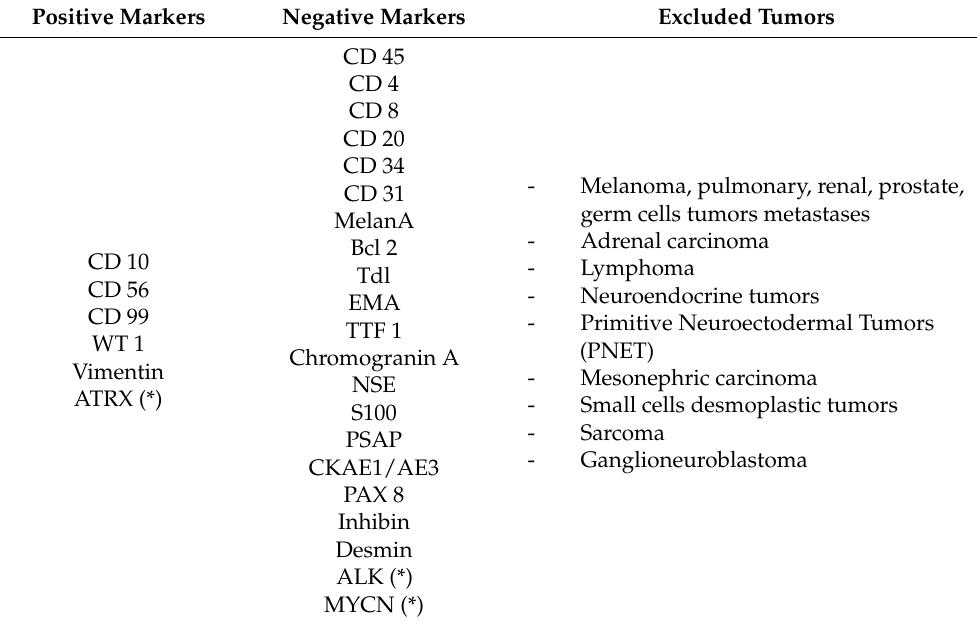
Table 2. Immunohistochemical stains, cytogenetic evaluation (*) and differential diagnosis. Positive Markers Negative Markers Excluded Tumors CD 10 CD 56 CD 99 WT 1 Vimentin ATRX (*)